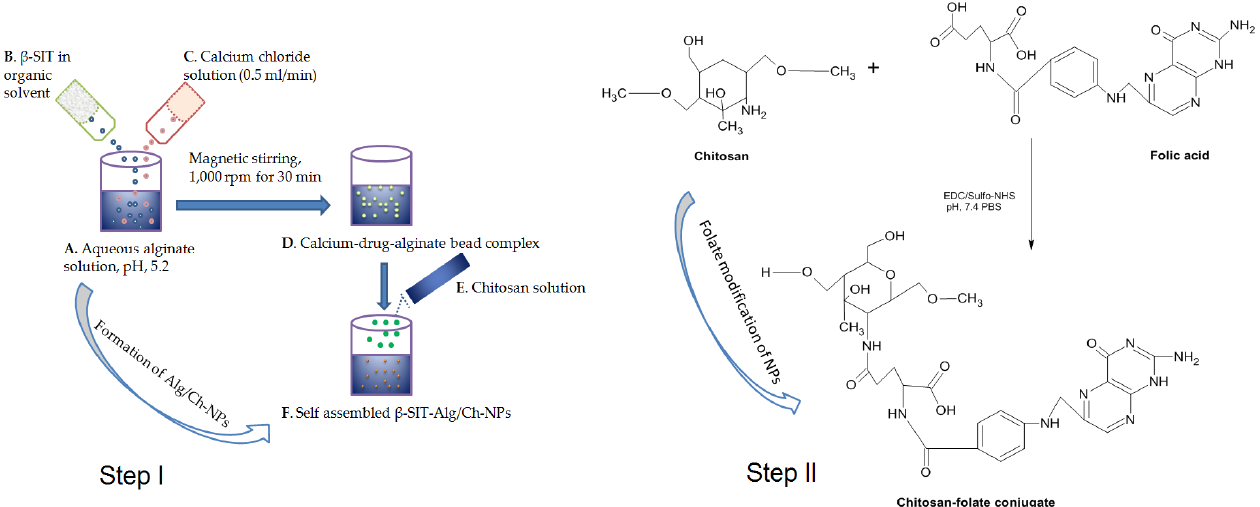
Figure 11. Outline representing the different steps in the preparation of β -SIT-Alg/Ch-NPs. Aqueous alginate (1 mg/mL) solution pH adjusted to 5.2 ( A ); Transfer of β -SIT solution in alginate solution ( B ); Calcium-chloride solution added to alginate solution ( C ) at flow rate of (0.5 mL/min) with magnetic stirring, 1000 rpm for 30 min, forming a complex of calcium-drug-alginate beads ( D ); Chitosan solution added dropwise to alginate solution ( E ), leading to formation of self-assembled β -SIT-Alg/Ch-NPs ( F ). Step I involves formulation of β -SIT-Alg/Ch-NPs, while Step II indicatesfolate modification of NPs.